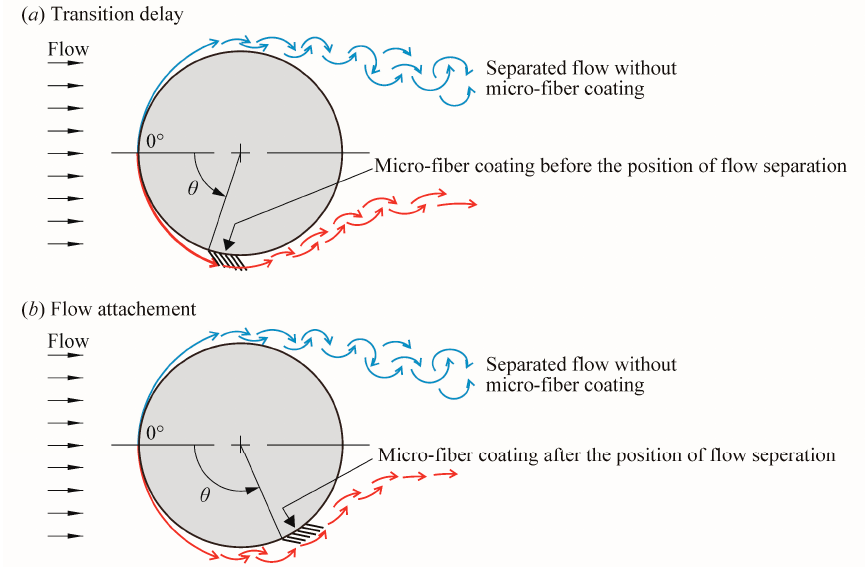
Figure 1. A schematic description of flow control of bluff body by hair-like surface: ( a ) Transition delay; ( b ) Flow attachment.